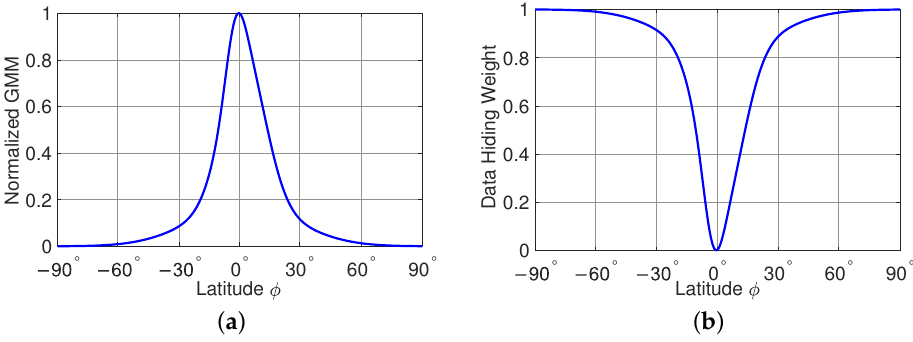
Figure 8. Normalized GMM for the latitude: ( a ) Normalized relative viewing direction frequency ˆ f ( φ ) , ( b ) Data hiding weight function w